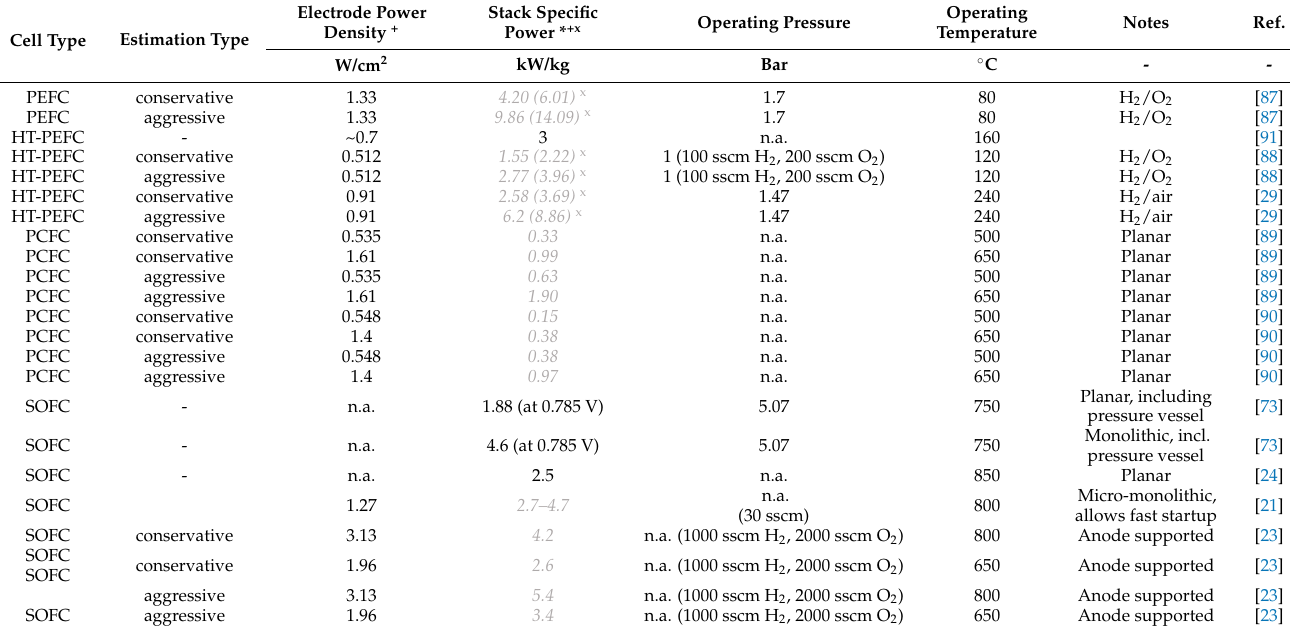
Table A1. Summary of the performance characteristics of lab-stage FC developments. Values in grey italic font have been calculated/estimated using the assumptions described above, while values in standard font have been taken directly from the cited